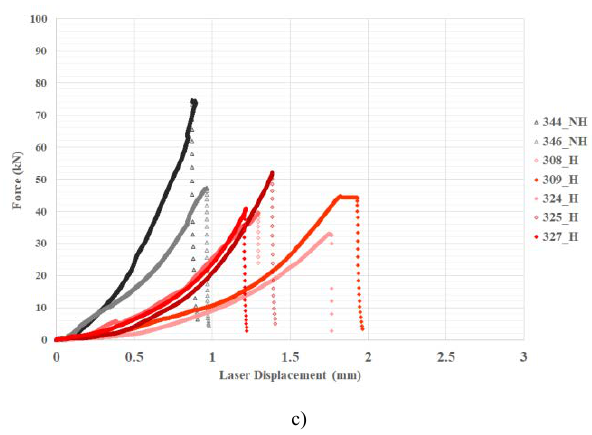
Fig. 10 Force-displacement curves for samples tested at displacement rate a) 0.125 mm/min b) 0.5 mm/min c) 1.0 mm/min.